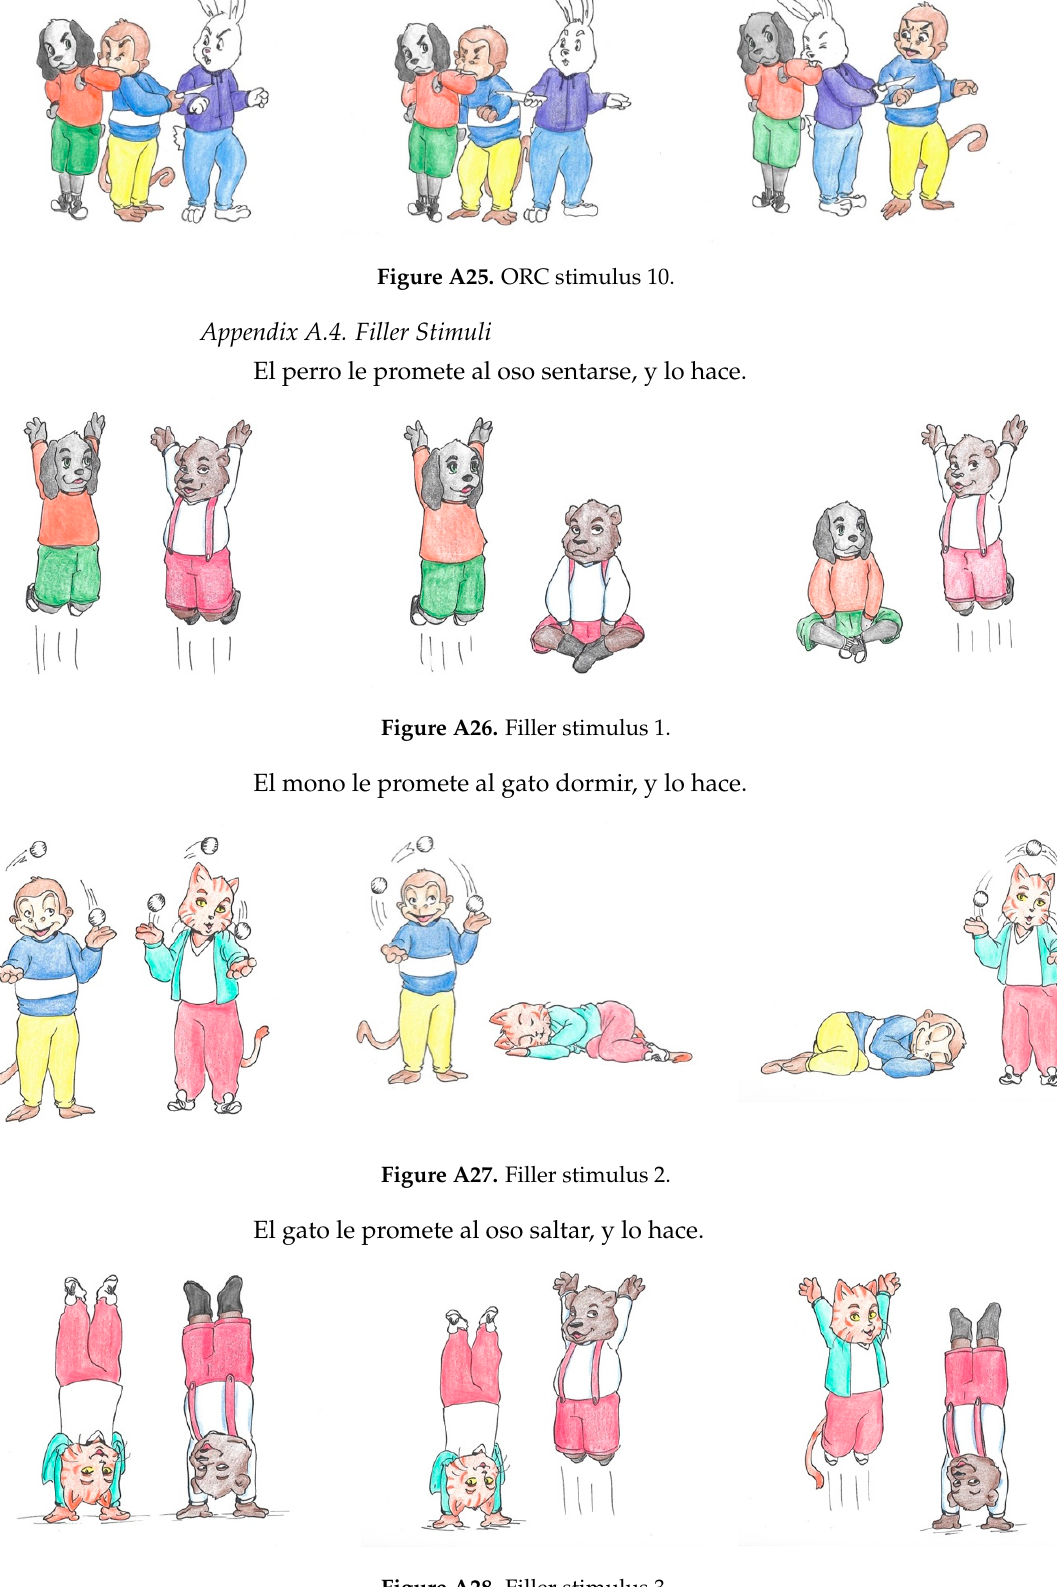
Figure A24. ORC stimulus 9.